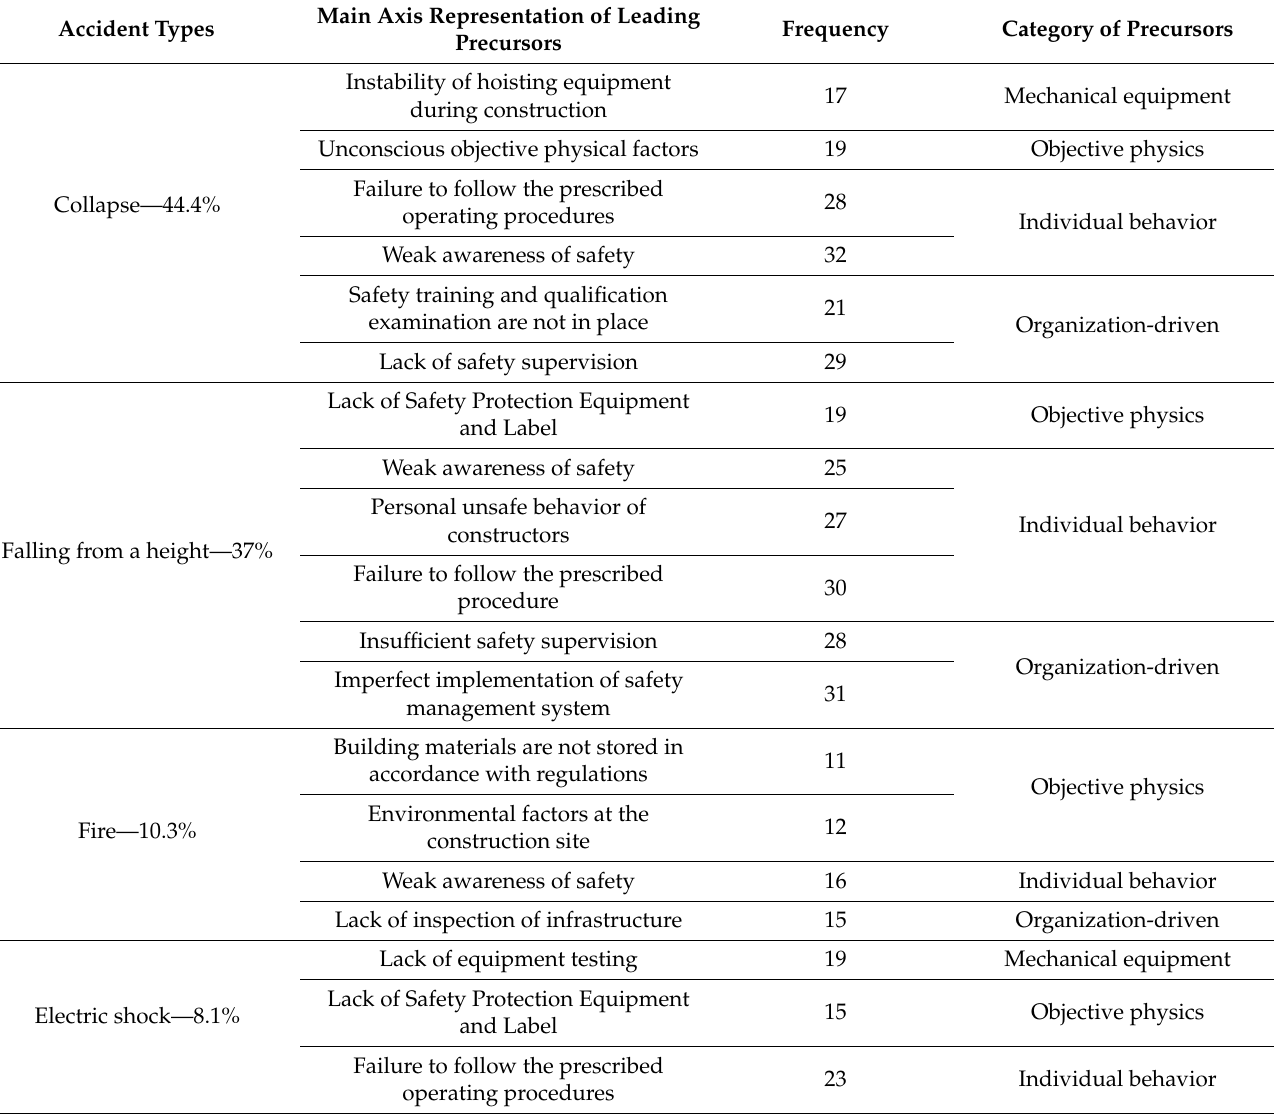
Table 4. The comparison of precursors of different accident